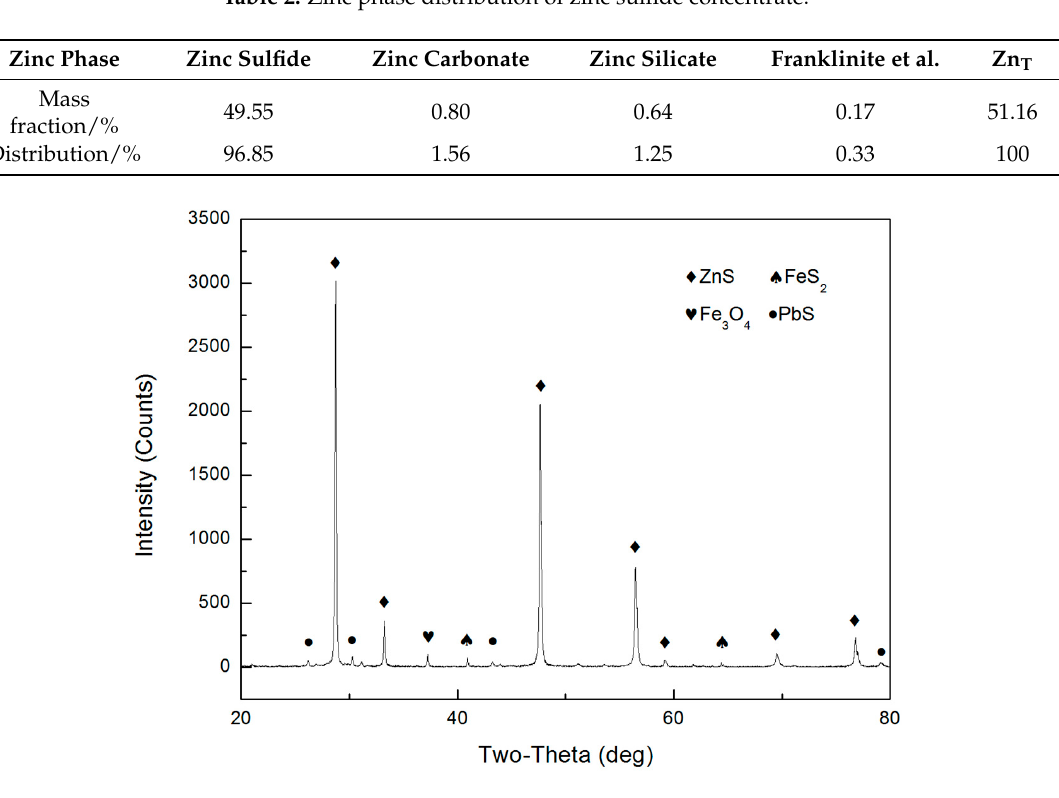
Figure 1. XRD pattern of zinc sulfide concentrate.